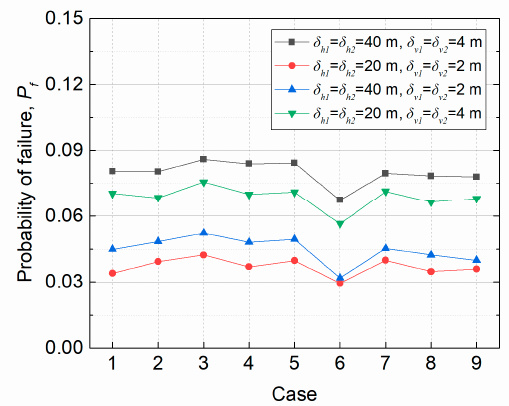
Figure 7. Influence of scale of fluctuation (SOF)on slope failure probability. Appl. Sci. 2020 , 10 , x FOR PEER REVIEW